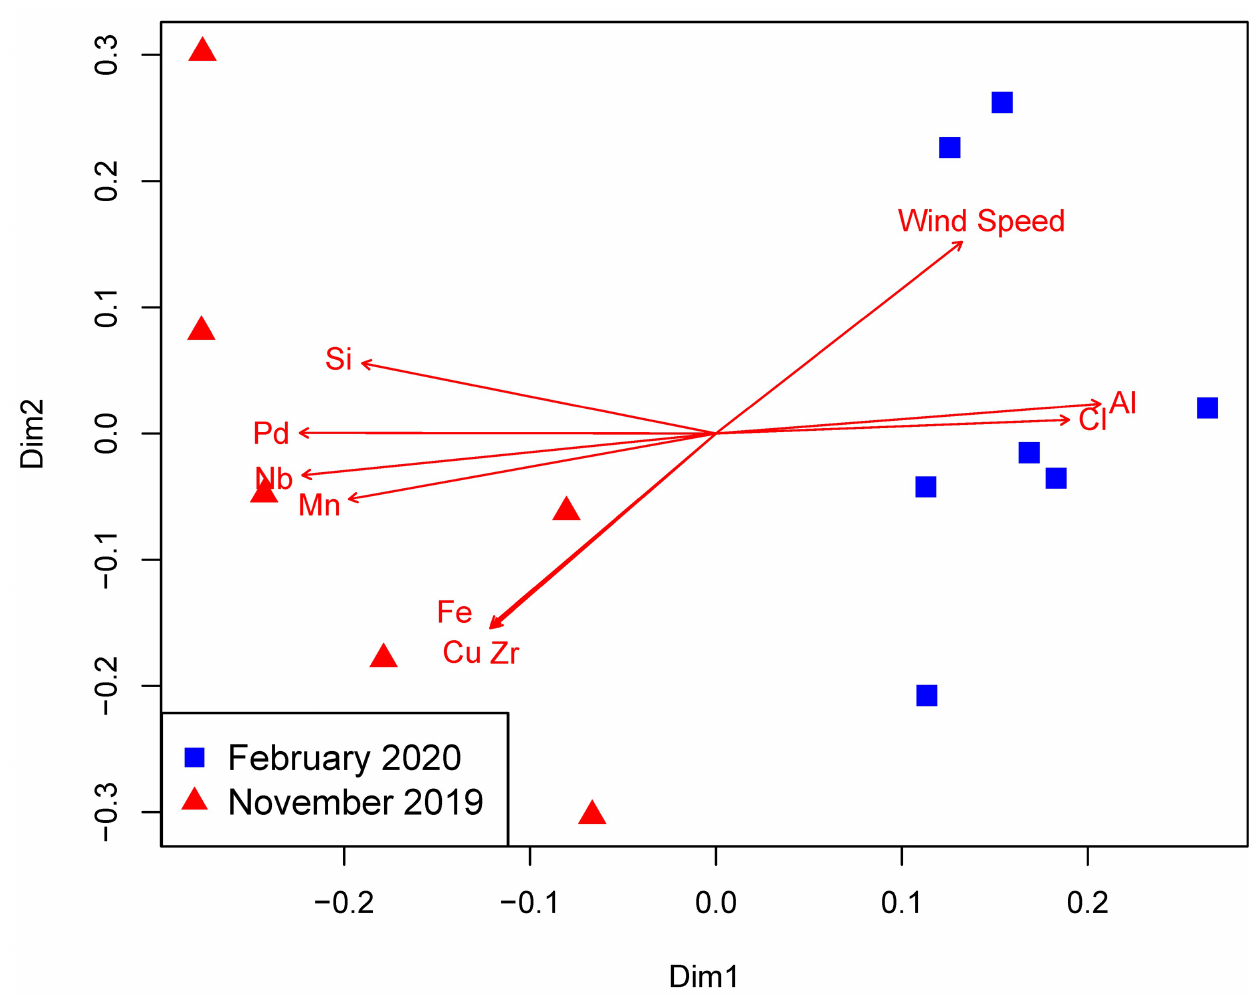
Figure 5. PCoA (principal coordinate analysis) plot of prokaryotic communities. Environmental factors that have significant correlation with the ordination (with p value lower than 0.01 and R-square value larger than 0.5) based on permutation tests are shown as red